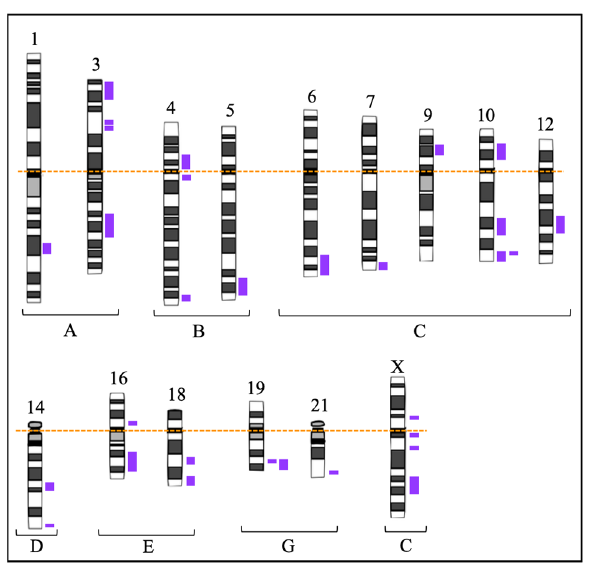
Figure 2. Ideogram of chromosomes following Denver’s group nomenclature summarizing the mapping of 28 unusual and clinically significant LCSHs, indicated by purple bars, identified by CMA in 7/8 patients with MDS and with karyotype without numerical and/or structural chromosomal changes. Legend: A dotted orange line was added to indicate the alignment of chromosomes by